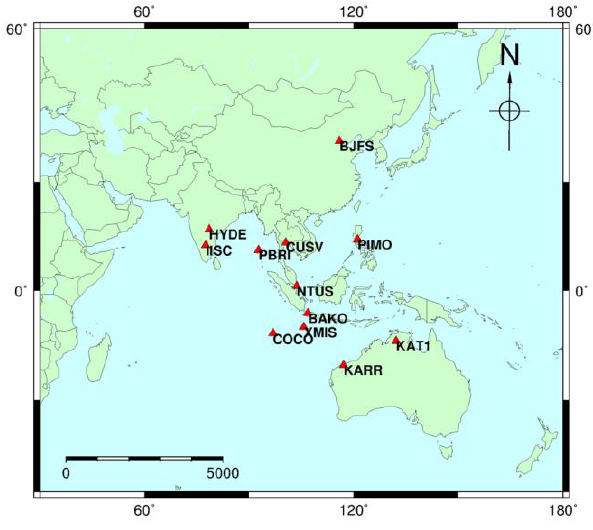
Figure 2. IGS stations adopted in realising frame definition in ITRF2014.